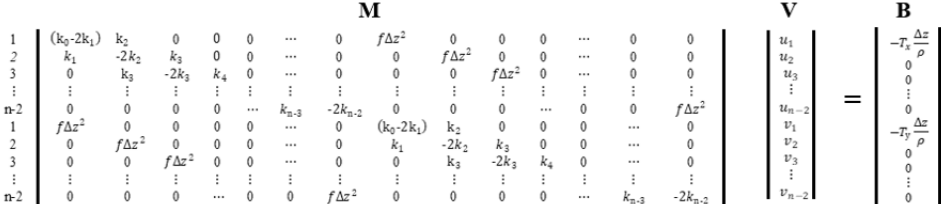
Figure 4. Profile variations for turbulent viscosity with depth. Very stratified column water (consec- utive dots) and low stratified column water (dashed lines).